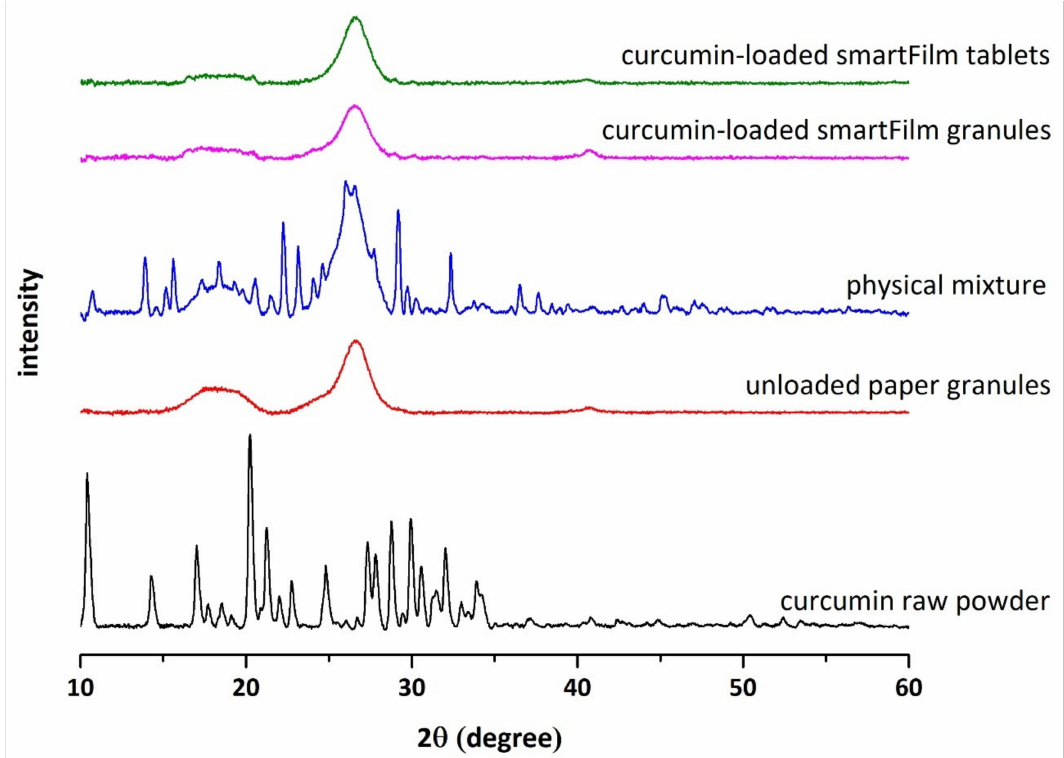
Figure 4. X-ray diffraction patterns of pure curcumin raw powder, unloaded paper granules, physical mixture, curcumin-loaded smartFilm granules, and curcumin-loaded smartFilm